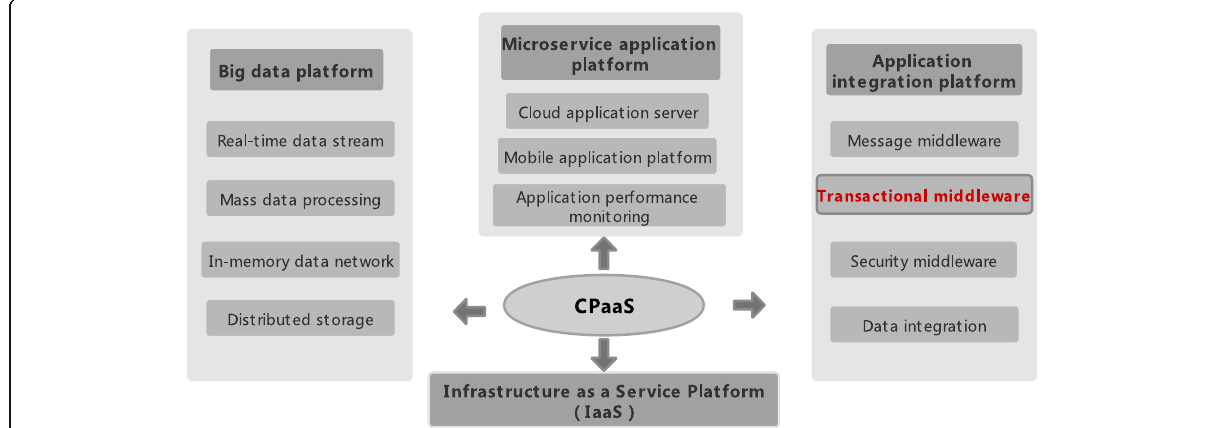
Fig. 13 Overall CPaaS cloud platform. Our transactional middleware is deployed in the application integration platform, i.e., the part identified as red in the figure